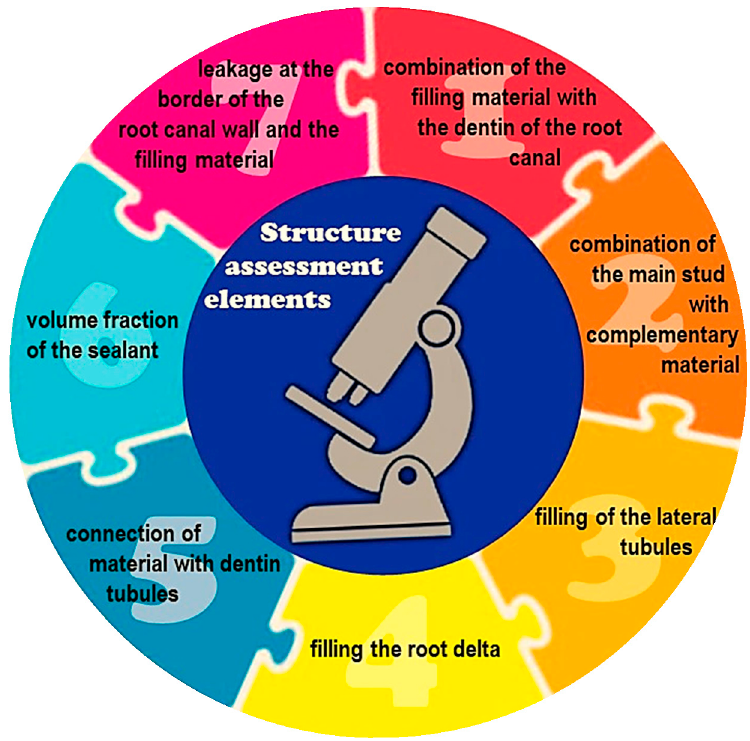
Figure 13. Criteria for the evaluation of the research material depending on the variants of develop- ment and obturation of the root canal.